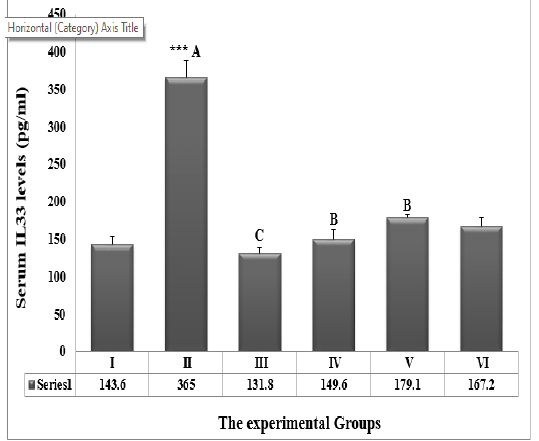
Figure.4. The effect of gugglsterone on IL 33 levels in the surem of OVA-induced asthma in rats. Values are indicated as (means ± Std. Error (n=8) for each group. Group I: Control group, Group II: Positive control group (with sensitization), Group III: Guggulsterone (25 mg/kg) with sensitization, Group IV: Guggulsterone (50 mg/kg) with sensitization, Group V: Prednisolone (4.12 mg/kg) with sensitization, Group VI: guggulsterone (50 mg/kg) without sensitization. *** symbol referred to significant different (p<0.001) compared to control group, unpaired test student t-test. Groups with non- identical letters are significantly different (p<0.05).